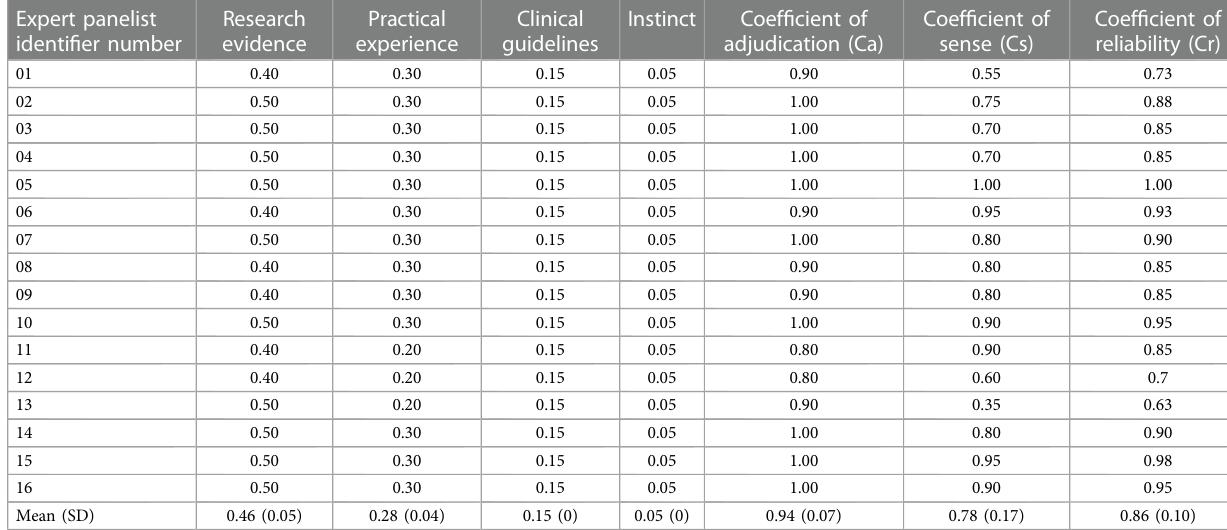
TABLE 2 Quantitative assessment of familiarity of modi fi ed Delphi study panelists with child injury.